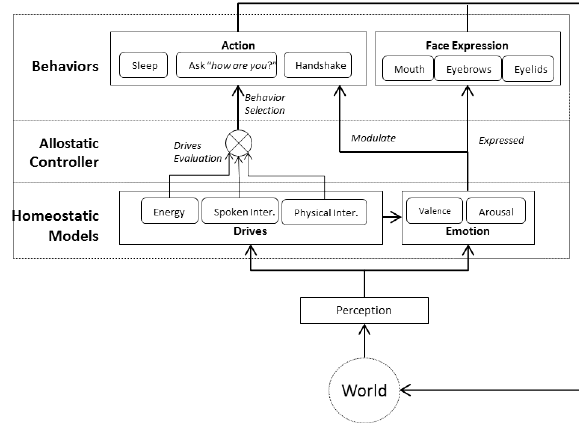
Figure 6: Detailed diagram of the behavior generation. The world is perceived, impacting the drives and emotions. Drives are then eval- uated by the allostatic controller which selects an action from the pool of available behaviors and execute it. The behaviors shown on the diagram are just a subset example to illustrate the principle: if a human partner is perceived while the drive for spoken interaction is high, the allostatic controller may elect the action «Ask: How are You?»; in the case of a high physical interaction drive it may prefer the «Handshake» action. In the eventuality of a critical energy need, the robot will ignore the human and set itself to sleep mode. As a parallel process, emotions are constantly updated based on the content of the environment and the global satisfaction of the drives. In turn, emotions are expressed through facial expression and they modulate the execution of